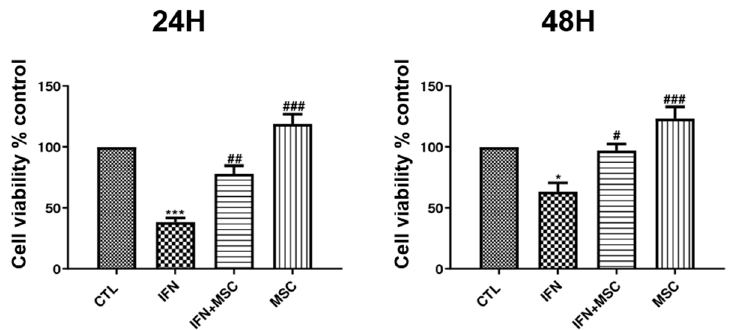
Figure 1. The effect of hHMSC treatment on the viability of hORSCs was evaluated by the MTT assay. Cell viability was detected in hORSCs (control), hORSCs treated with IFN- γ , hORSCs treated with IFN- γ and co-cultured with hHMSCs, and co-cultures of hORSCs and hHMSCs. Cell viability was increased in the hHMSC coculture. Error bars represent the mean ± SEM, n = 3. Sta- tistically significant at * p < 0.05 and *** p < 0.001, compared to the control and # p < 0.05, ## p < 0.01, and ### p < 0.001 compared to the IFN- γ -treated group.